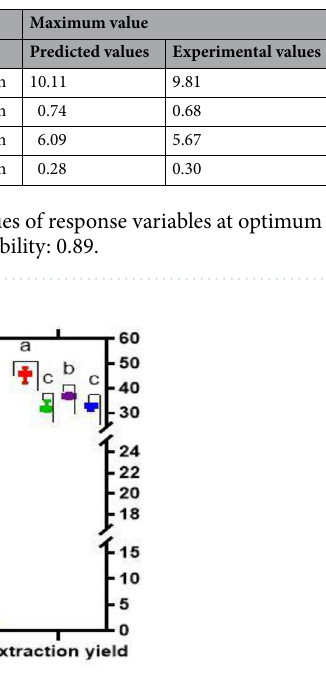
Figure 3. Comparative study between conventional extraction methods and UAE. The different levels of TPC; TFC, FRAP and IC50 DPPH are associated with the Y-axis on the left while the extraction yield is associated with the X-axis on the right. ns non-significant difference; and all factors sharing no letters in common are significantly different at p value ( p ≤